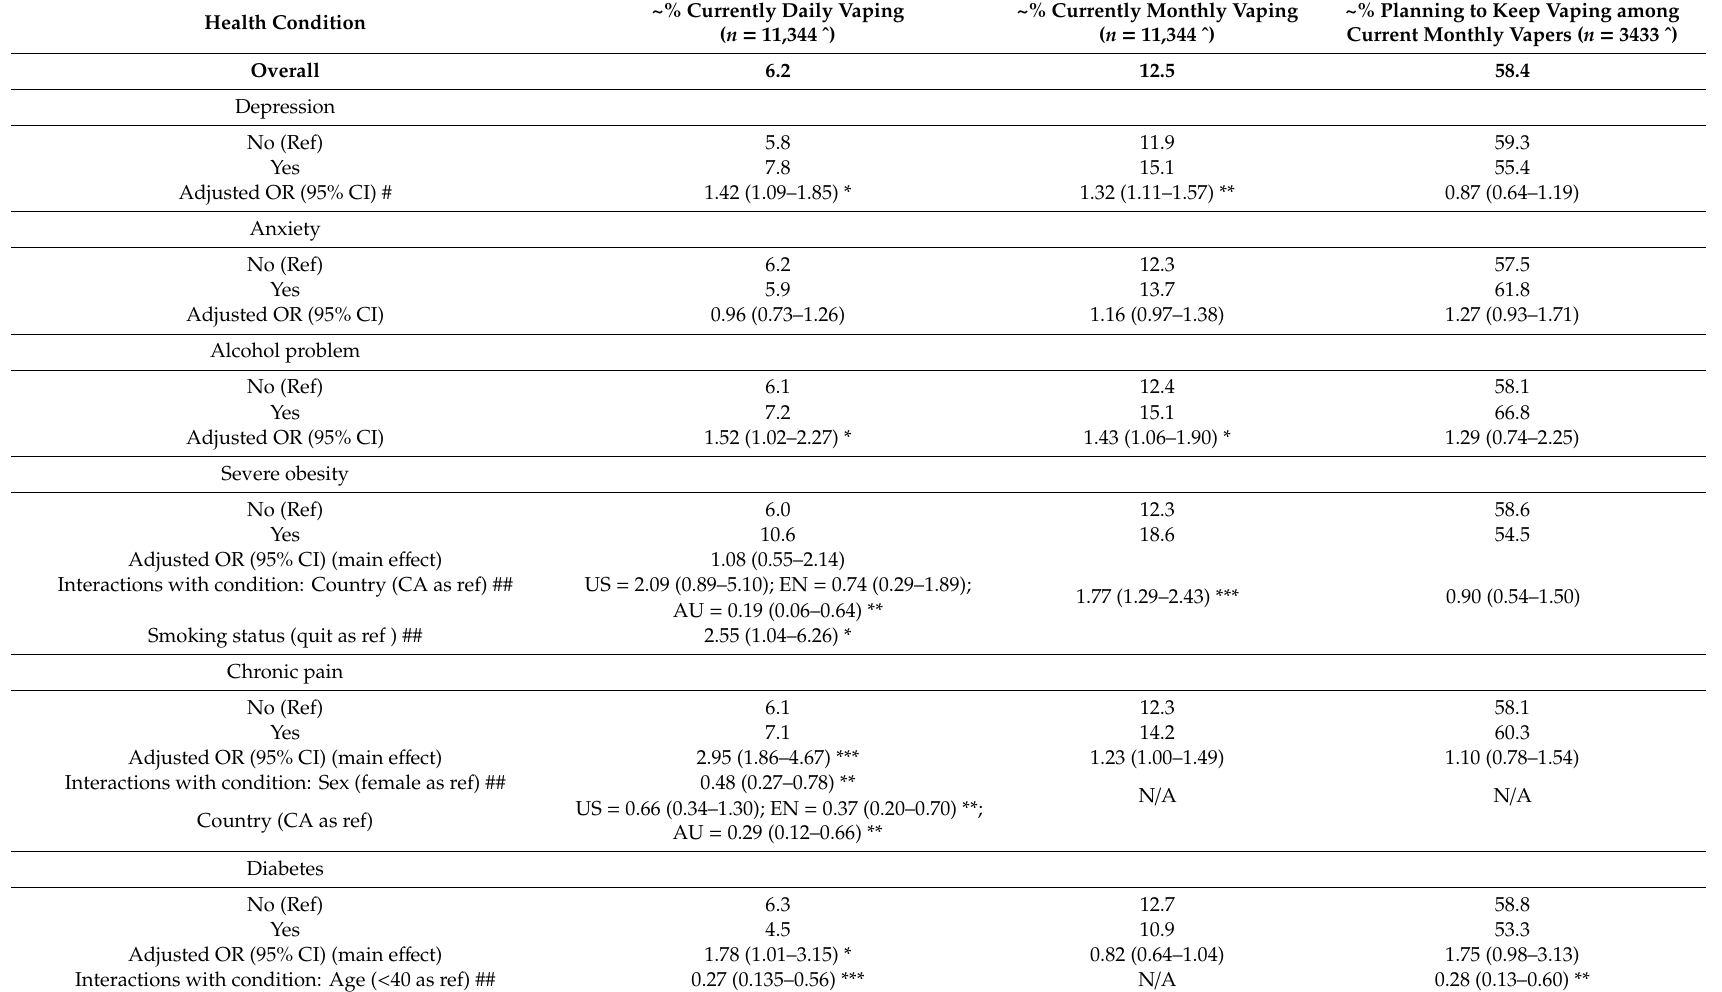
Table 3. Association between self-reported health problems and vaping activities (in all 4 countries)